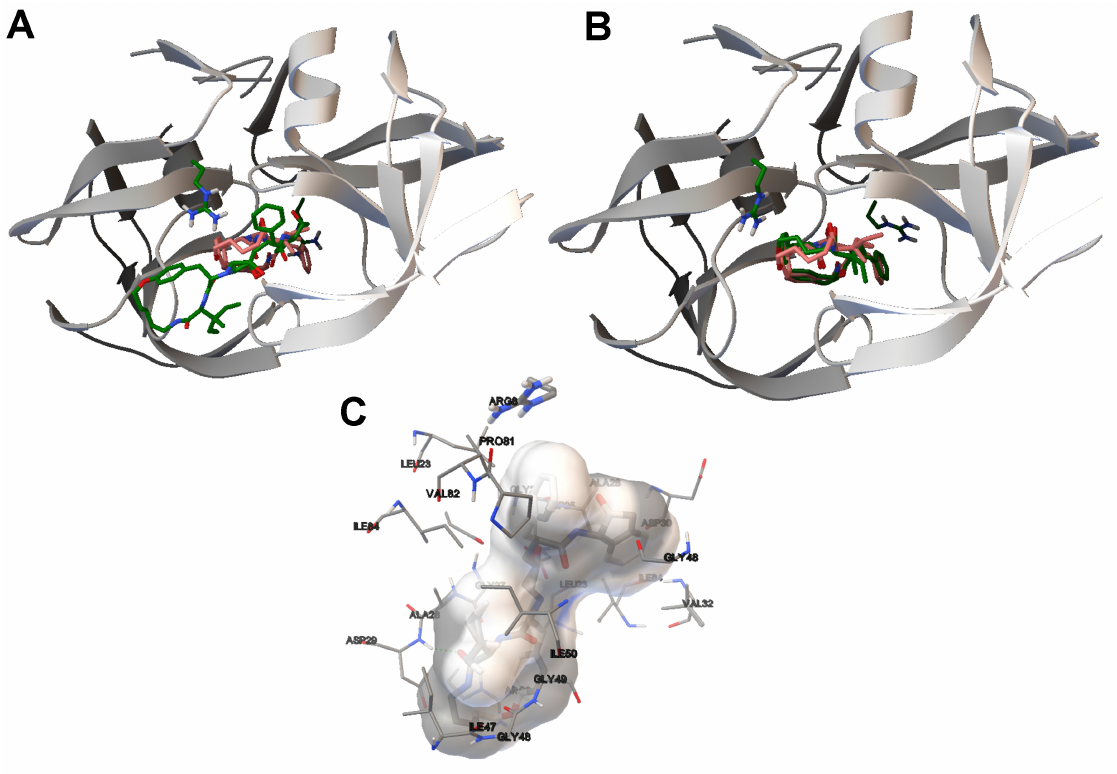
Figure 6. ( A , B ) The ligand conformation for instance 1D4K that has been generated by the LGA and SMPSO algorithms, respectively. The computed ligand conformations are in green and the reference ligand in orange. ( A , B ) show the HIV-protease in 3D, in grey; ( C ) The molecular interactions between the ligand conformation returned by the SMPSO algorithm and the receptor. The H-bonds are represented by green spheres. The amino acids closest to the computed ligand have been